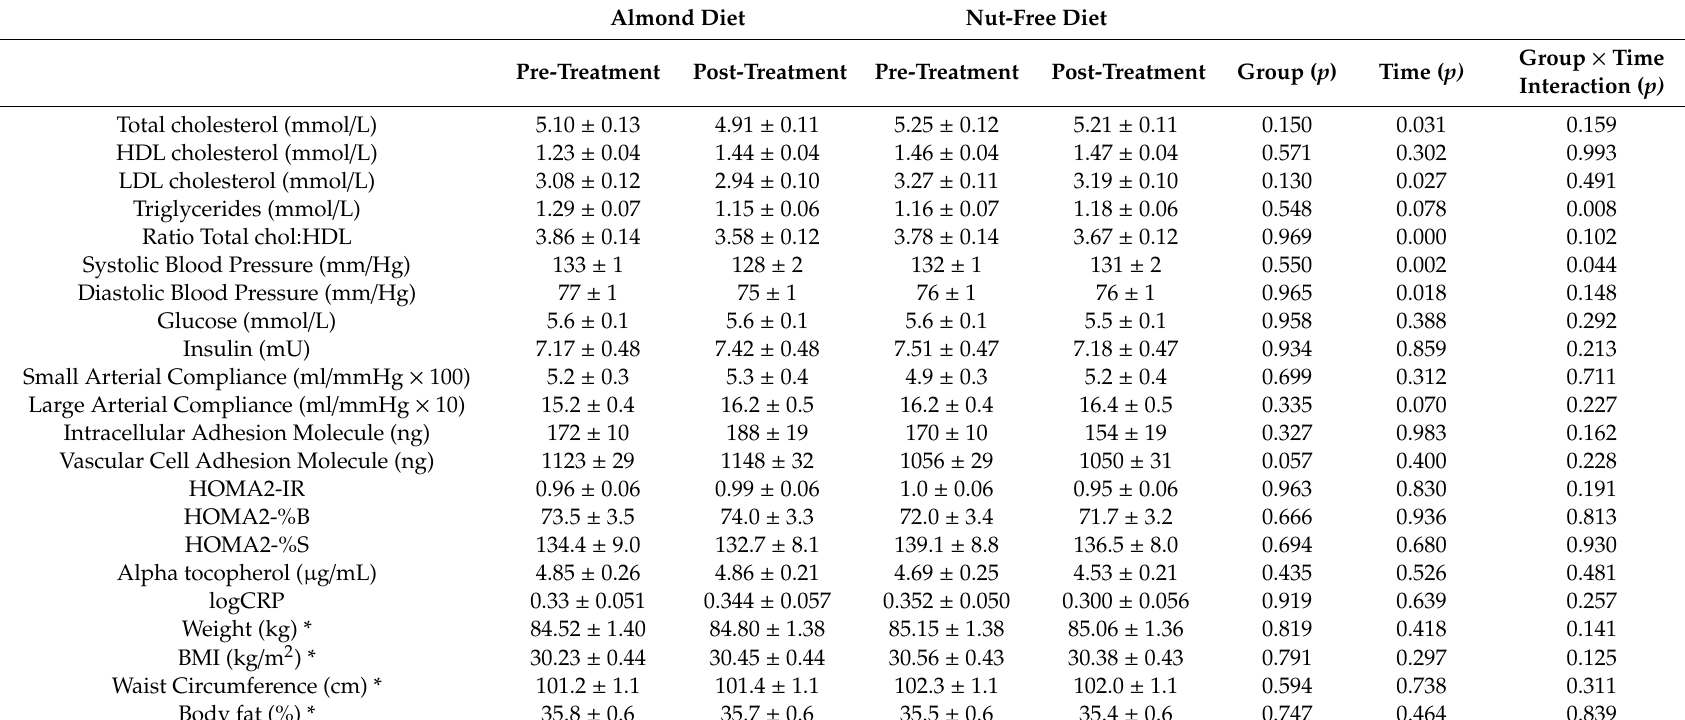
Table 5. E ff ect of Treatment on Cardiometabolic